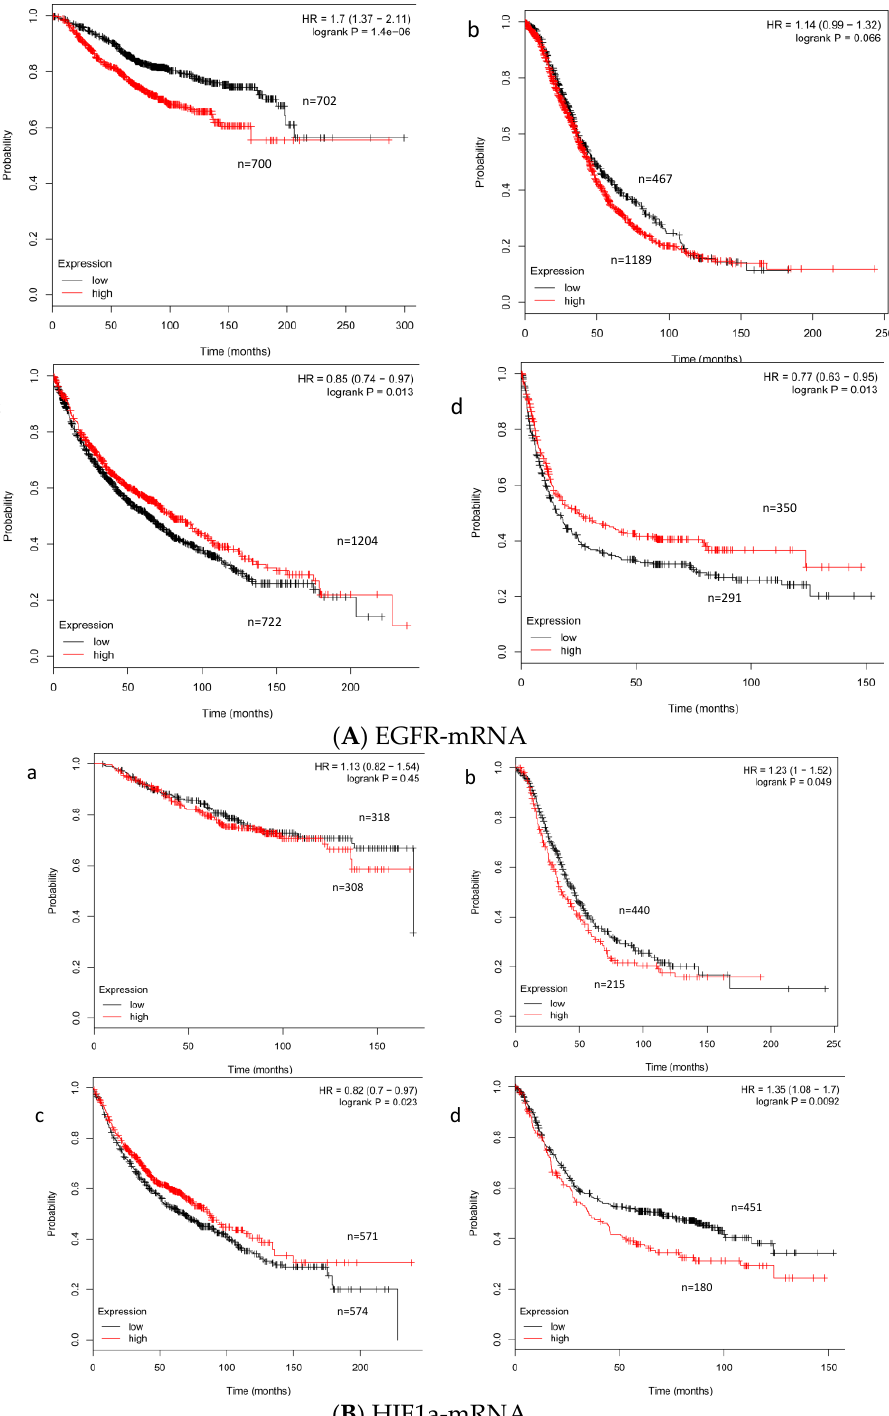
Figure 7. Comparative data on to the impact of EGFR (7A) and HIF-1α (7B) mRNA expression on the overall survival of breast ( a ), ovarian ( b ), lung ( c ), and gastric ( d ) cancer patients. Plots were drawn by the Kaplan-Meier Plotter algorithm (Available online: http://kmplot.com/analysis) (accessed on 22 October 2018.) usingdata of the EGFR probe 1565483-at and of the HIF-1α probe 200989-at. Abbreviations: HR—hazard ratio.